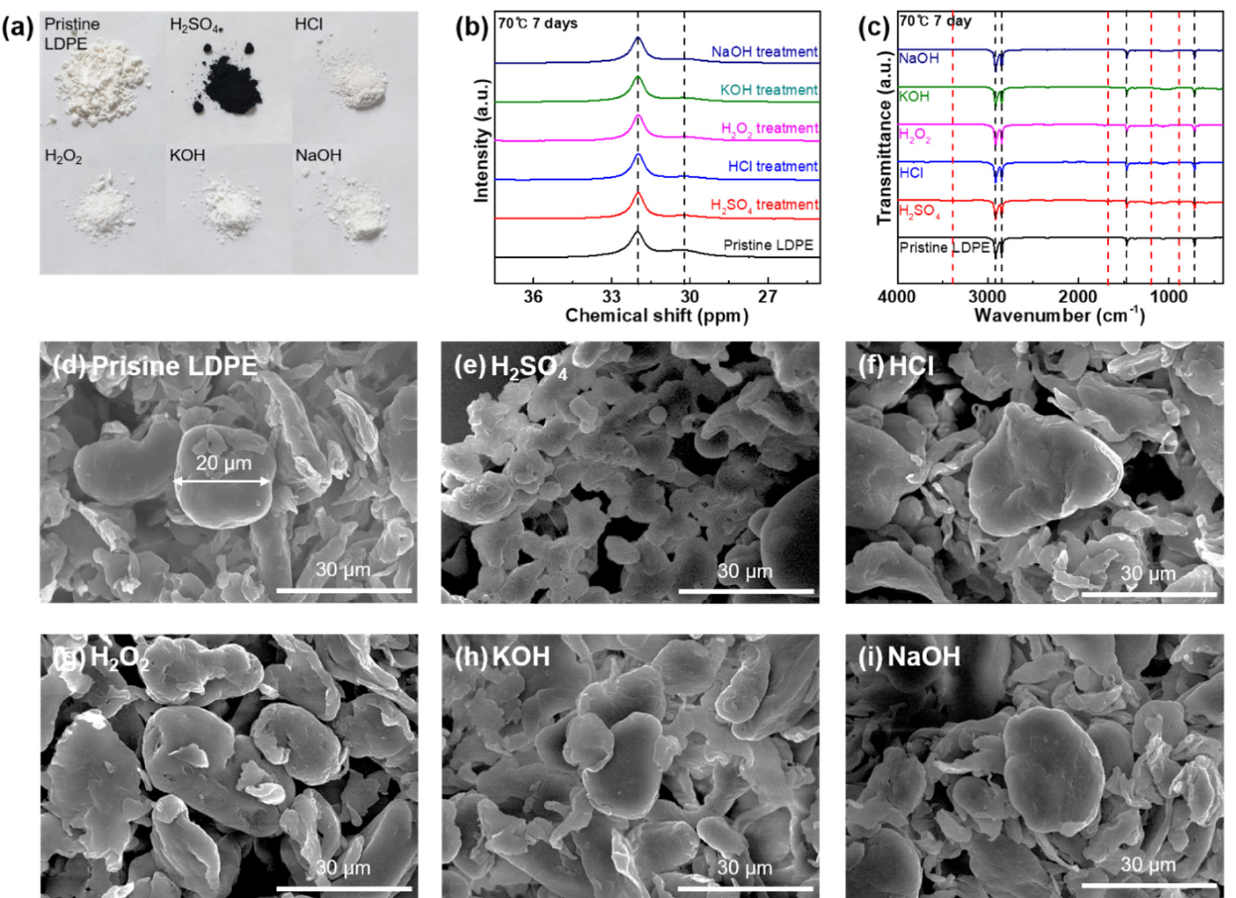
Figure 3. ( a ) Photograph of the LDPE samples in the pristine state and after chemical stability tests against strong acids, bases, and oxidizing agents (H 2 SO 4 , HCl, H 2 O 2 , KOH, and NaOH) used in the chemical digestion procedure at 70 °C for 7 d. ( b ) 13 C NMR spectra of LDPE in the pristine state and after the reaction with all the chemical agents at 70 °C for 7 d. ( c ) FT-IR spectra of LDPE in the pristine state and after the reaction with all the chemical agents at 70 °C for 7 d. ( d ) SEM image of pristine LDPE microparticles. SEM images of the LDPE microparticles after the reaction with ( e ) H 2 SO 4 , ( f ) HCl, ( g ) H 2 O 2 , ( h ) KOH, and ( i ) NaOH at 70 °C for 7 d.